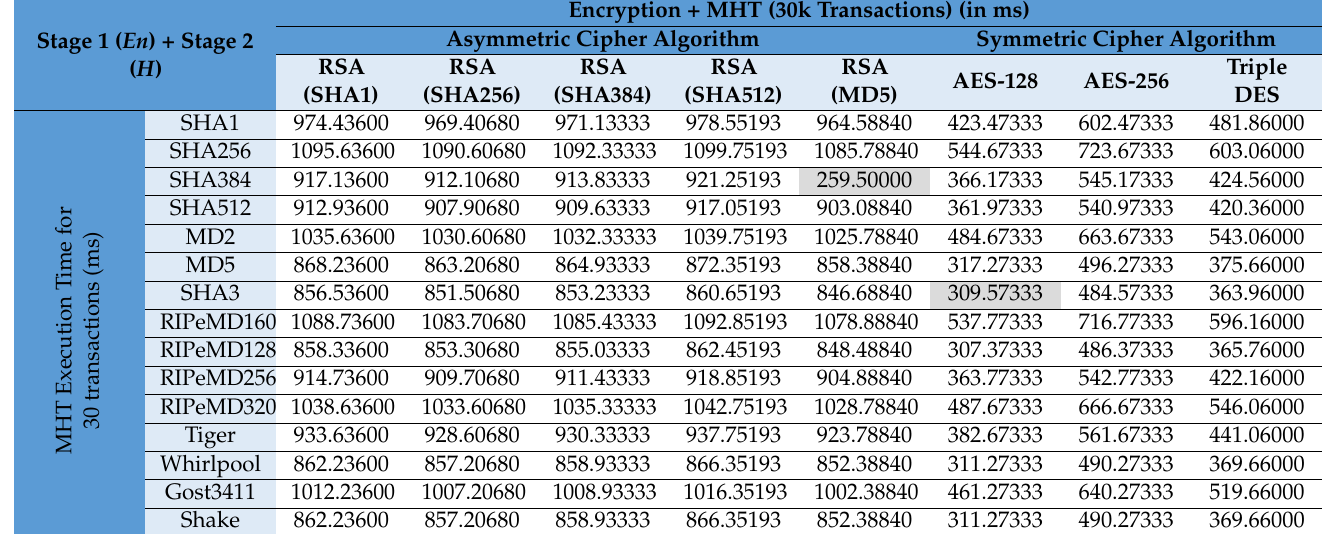
Table 3. Comparison of integrated signature and MHT algorithm execution time using 30k transac- tions dataset.